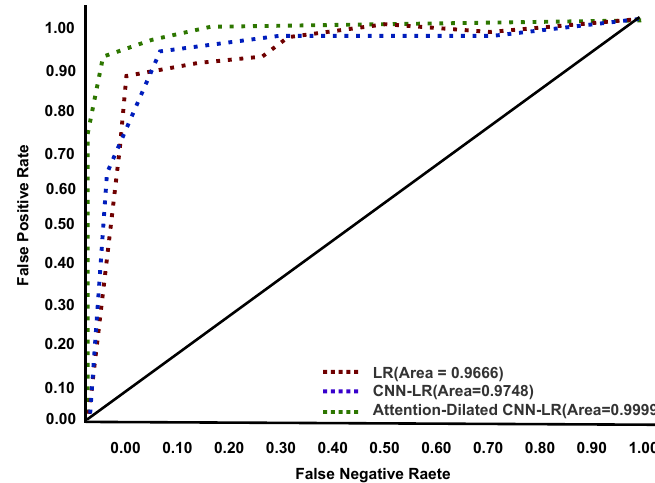
Figure 10. ROC curve during validation.